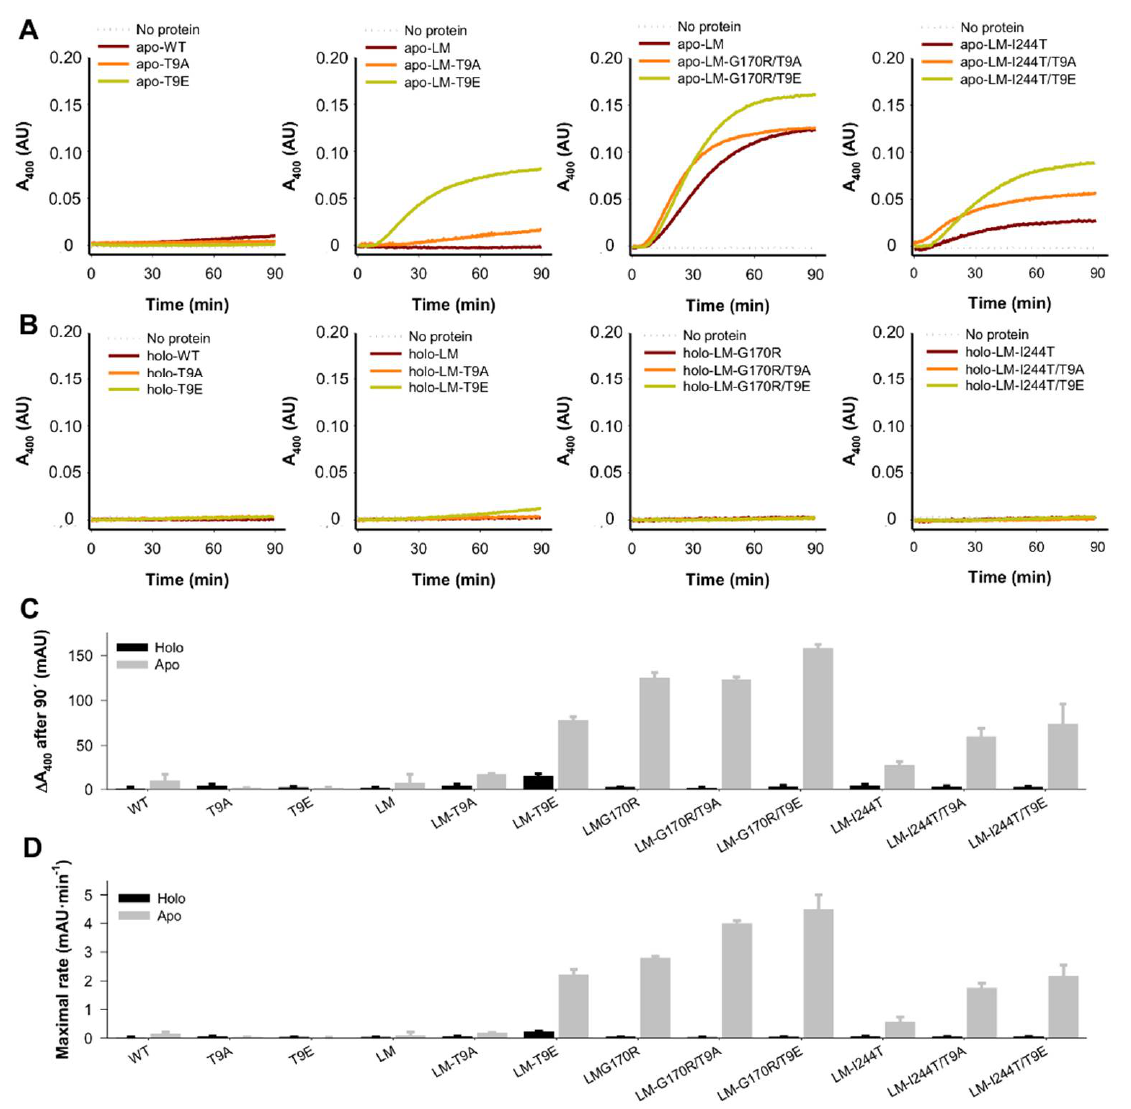
Figure 9. Aggregation kinetics of apo- and holo-AGT variants (WT, LM, LM-G170R, and LM-I244T) in the absence or presence of the T9A or T9E mutations. ( A , B ) Time-dependent turbidity (as an apparent A 400 ) measurements for apo- ( A ) and holo- ( B )AGT variants. Data are the average from three replicas. ( C , D ) Relevant kinetic parameters, as A 400 after 90 min ( C ) and the maximum of the first derivative of A 400 vs. time ( D ). Data in ( C , D ) are the mean ± s.d. from four replicas.